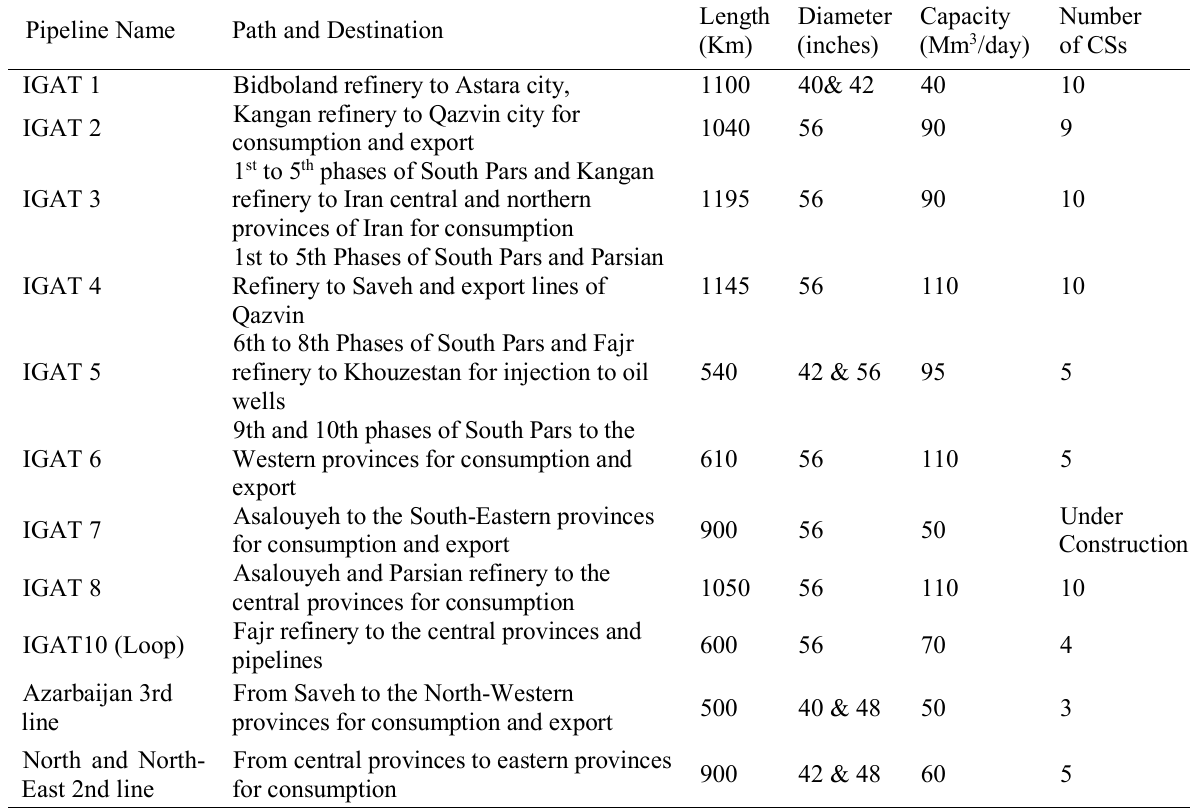
Table 1 . General Information about Iran Gas